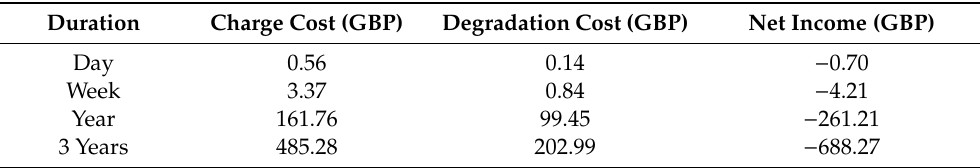
Table 2. Financial results of the baseline simulation across a working day, week, year, and three